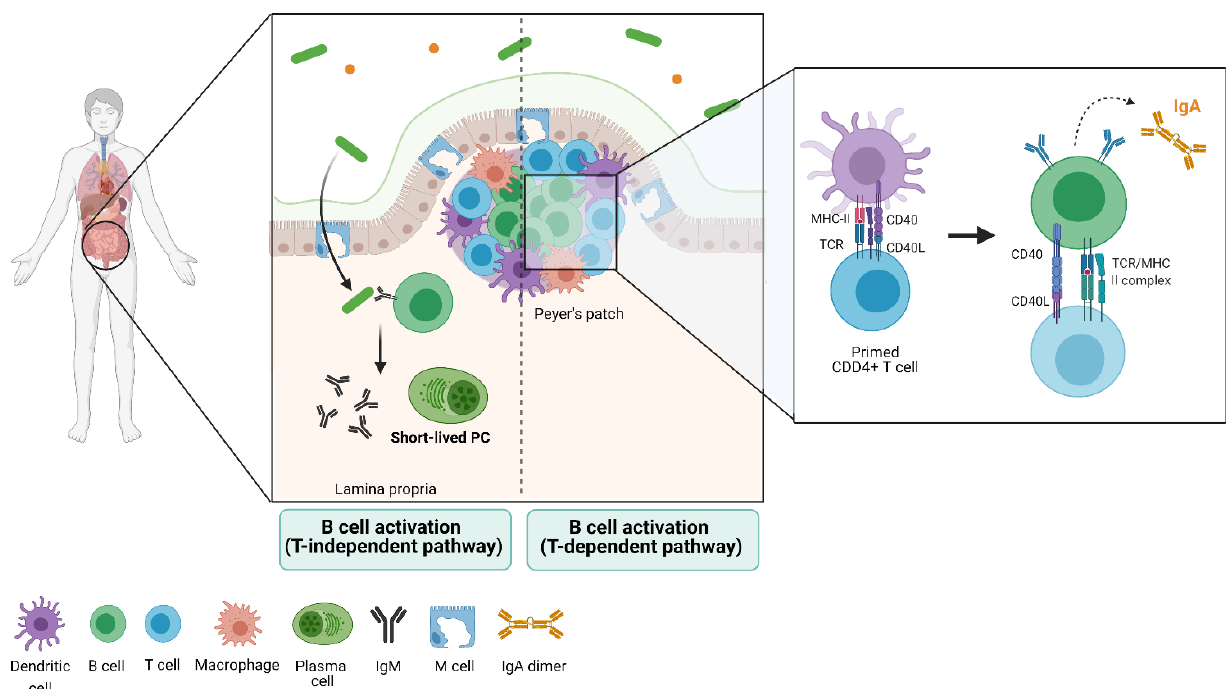
Figure 1. B-cell activation and response in the gut shape the gut microbiota through IgA secretion. When naïve B cells reach the mature state, they can activate and differentiate toward plasma cells (PC) through two pathways in the gut. B cells can encounter antigens in extrafollicular areas within the lamina propria, a process that induces their transformation into IgM-secreting PC. This pathway constitutes the T-independent activation of B cells. This population is characterized by low expression of the activation-induced deaminase (AICDA or AID), the reason why they do not undergo somatic hypermutation nor class switch recombination. Alternatively, B cells can enter the follicular areas located in the Peyer’s patches, where they closely interact with previously primed CD4+ T cells. These lymphocytes have already been in contact with dendritic cells and have experienced antigen presentation, allowing the T cells to activate B cells. This T-dependent activation induces proliferation of B cells, giving place to germinal centers (GCs) and expression of AID and BCL6. Together, these factors allow activated B cells to undergo somatic hypermutation, class switch recombination, and ultimately, IgA synthesis. Newly-secreted IgA binds the local bacteria and shapes the microbiota composition. This image has been created with